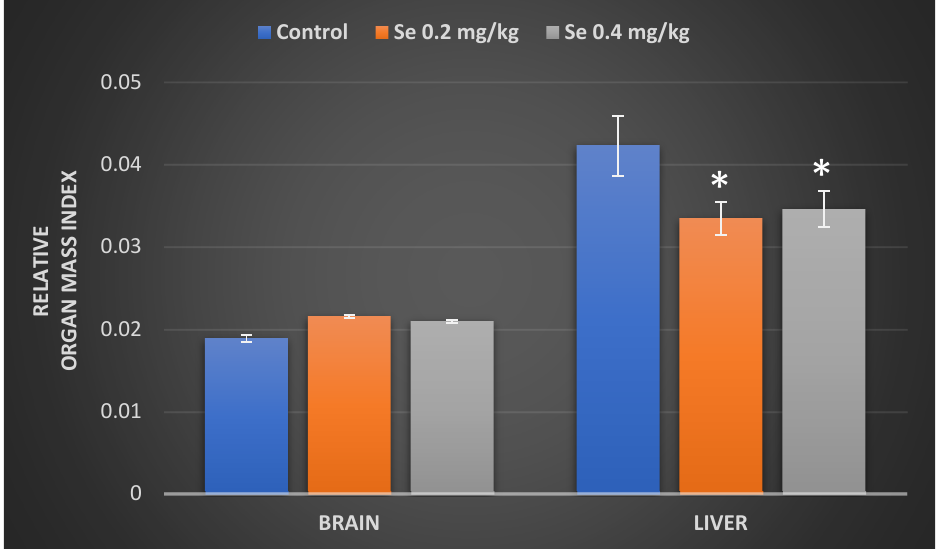
Figure 2. Relative mass index of the mice brain and liver (g of organ mass/g of body weight) of control group mice and mice orally treated with a Na 2 SeO 3 solution for 8 weeks. The model of selenium exposure to mice is described in the Methods section. The data were obtained by measuring the body weight and organ mass of 16 mice in each group. Results were expressed as the mean ± SEM. *—differences are statistically significant in comparison to the control group; p ˂ 0.05.